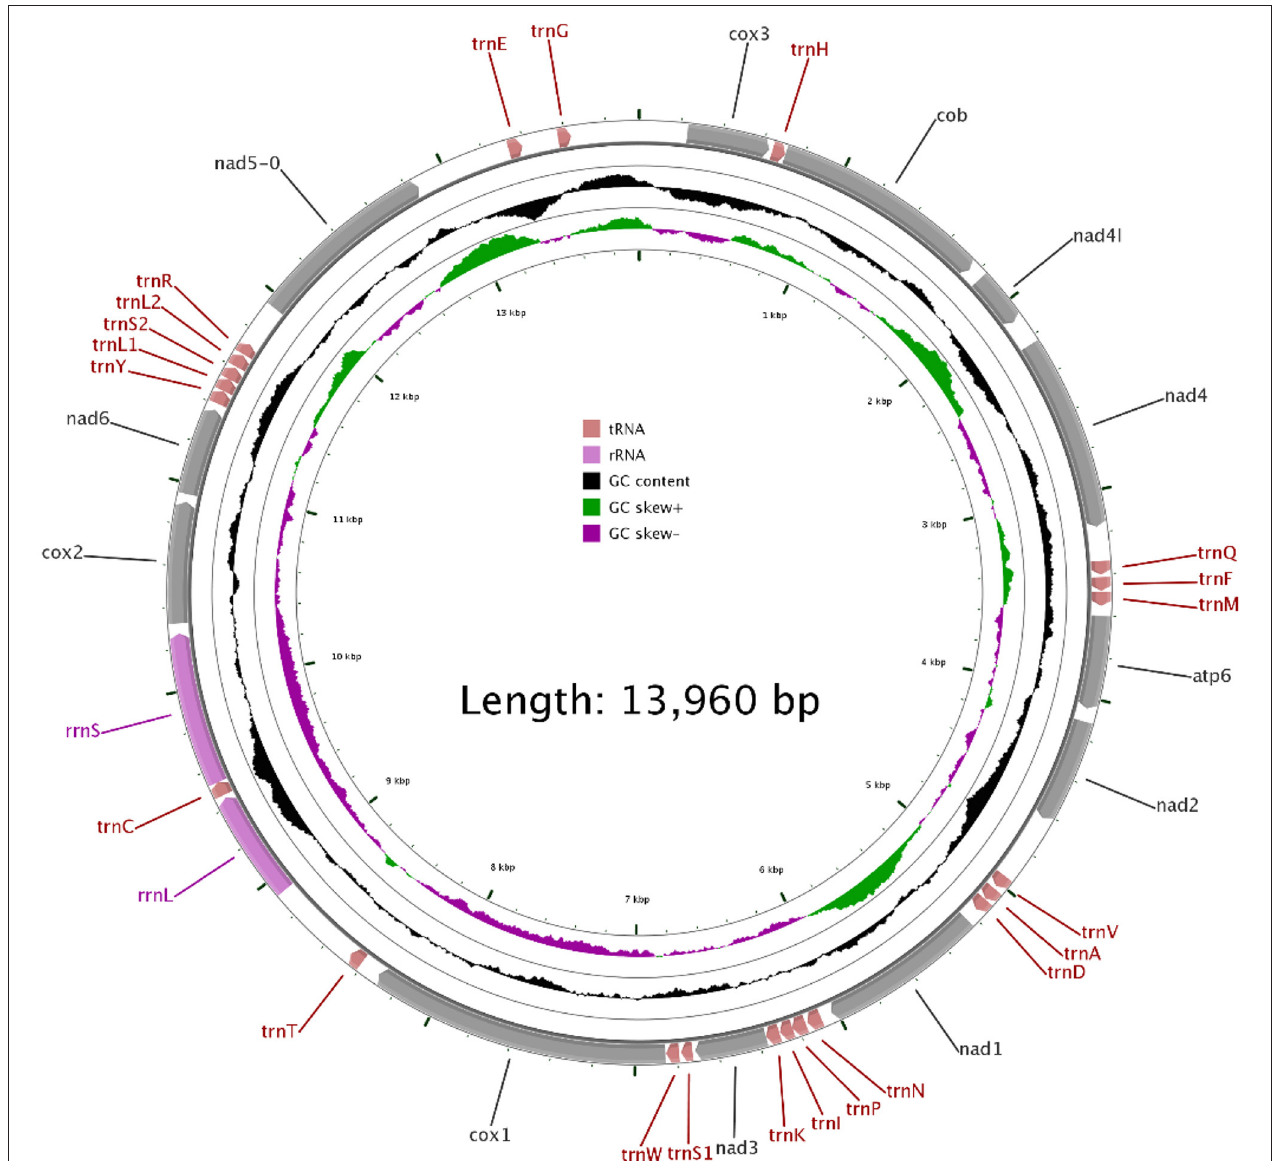
FIGURE 1 | The mitochondrial genome of F. intermediate from